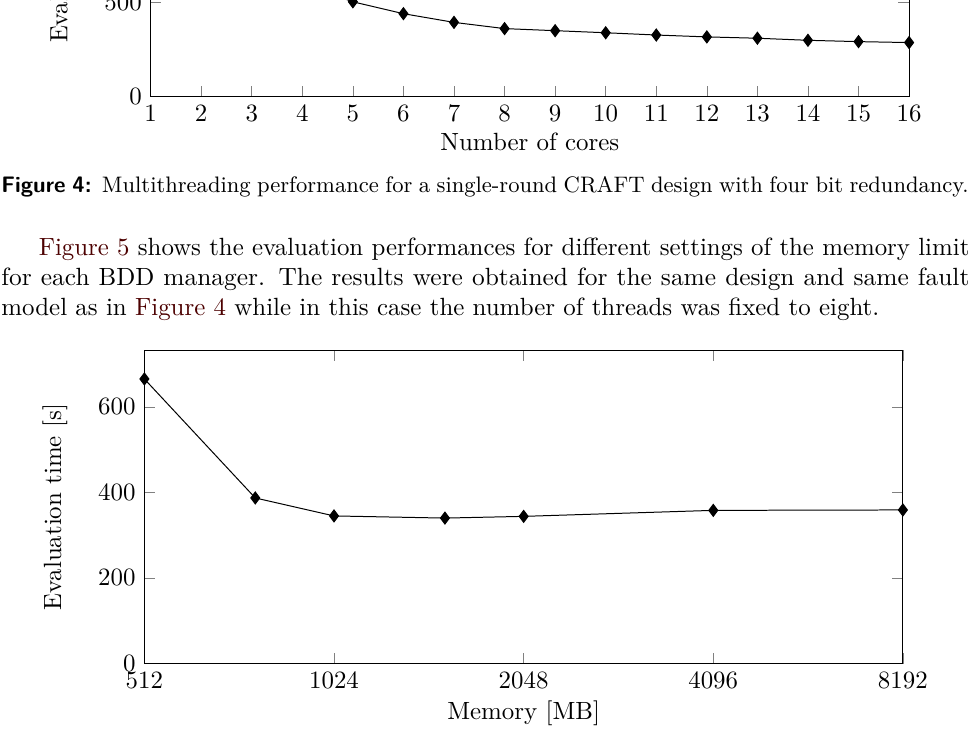
Figure 5: Dependency of the memory limit on the performance for an single-round CRAFT design with four bit